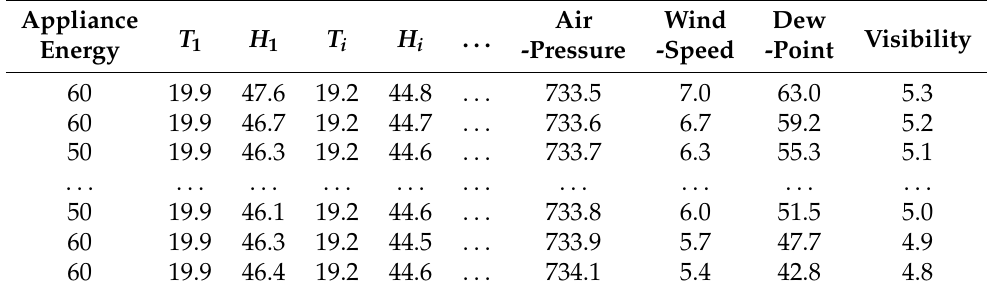
Table 5. Appliance energy dataset reprinted/adapted with permission from Ref. [11]. 2023,